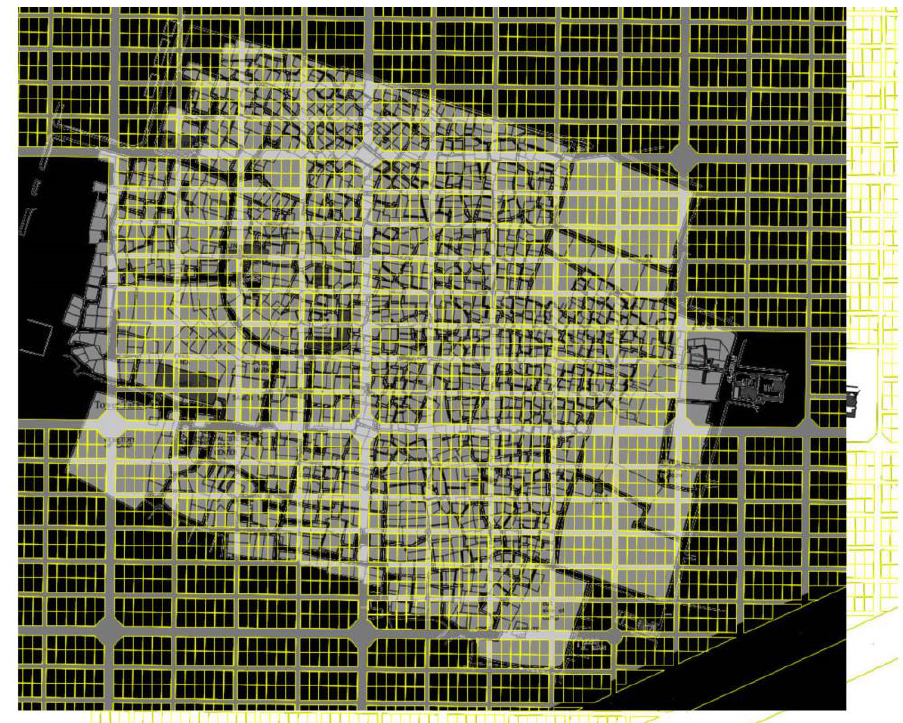
Diagram showing the superimposition of two camp scales, Baqa’a camp in yellow and Burj el-Barajneh camp in grey.